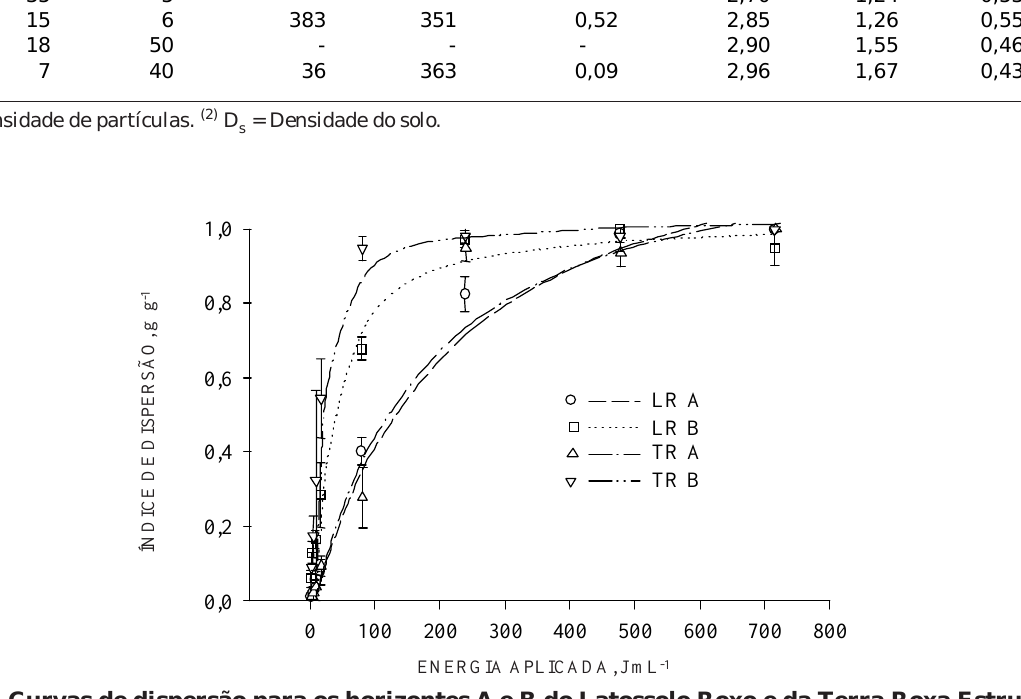
Figura 1. Curvas de dispersão para os horizontes A e B do Latossolo Roxo e da Terra Roxa Estruturada (dados normalizados, quatro